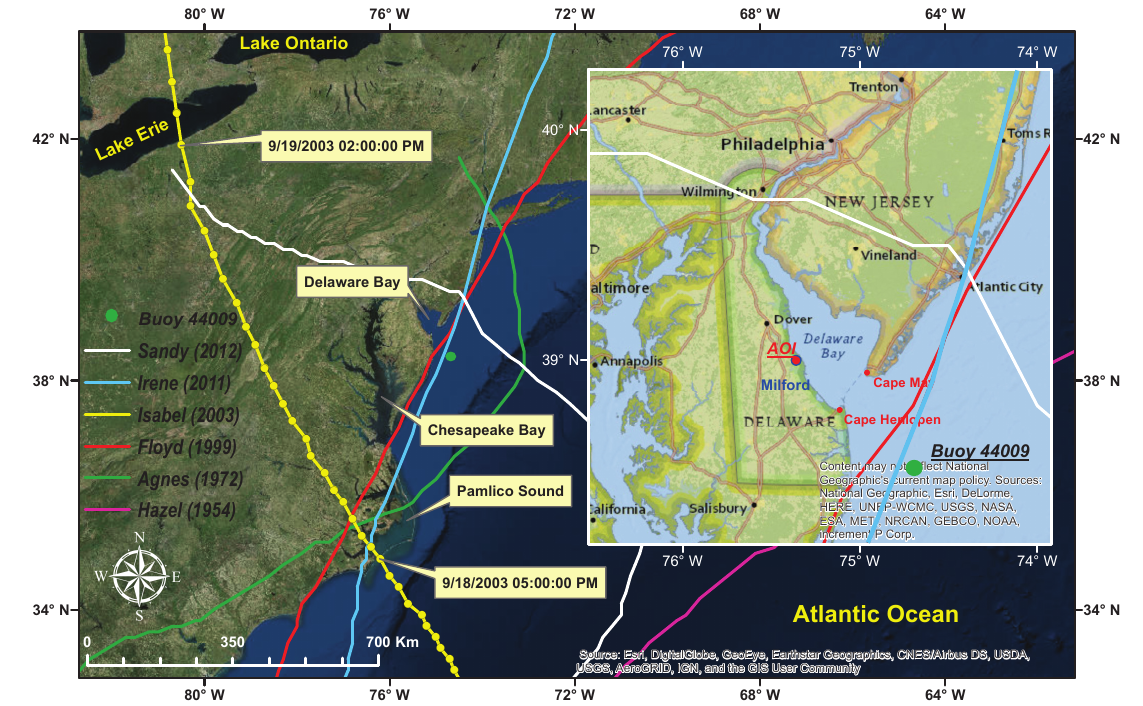
Figure 1. Location map for the area of interest. Six colored lines indicate major historical hurricane tracks within the